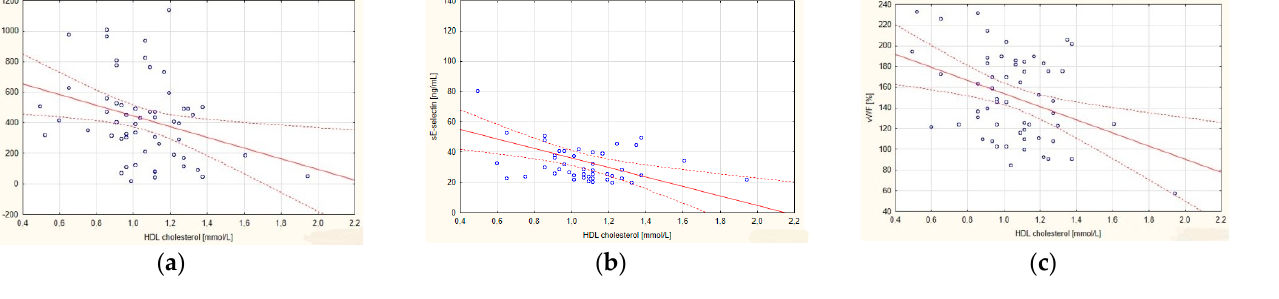
Figure 2. Correlations in the group of coronary artery disease (CAD) patients between the high- density lipoprotein cholesterol (HDL-C) fraction and ( a ) soluble ligand CD40 (sCD40L); ( b ) soluble E-selectin (sE-selectin); and ( c ) von Willebrand factor (vWF). The regression line is marked with a solid line, while the confidence intervals of 0.95 are marked with a dashed line.